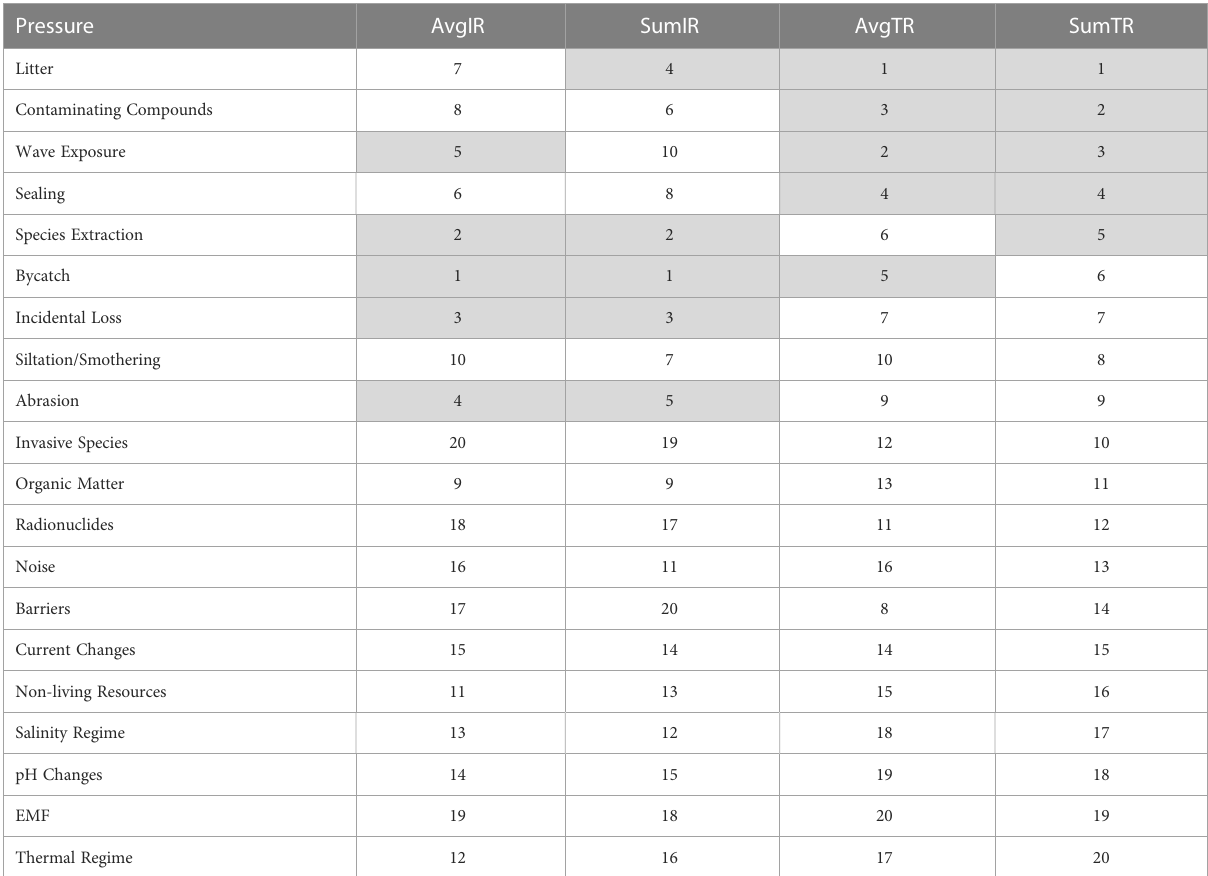
TABLE 4 Ranks for each Pressure and ranking index used. Pressure